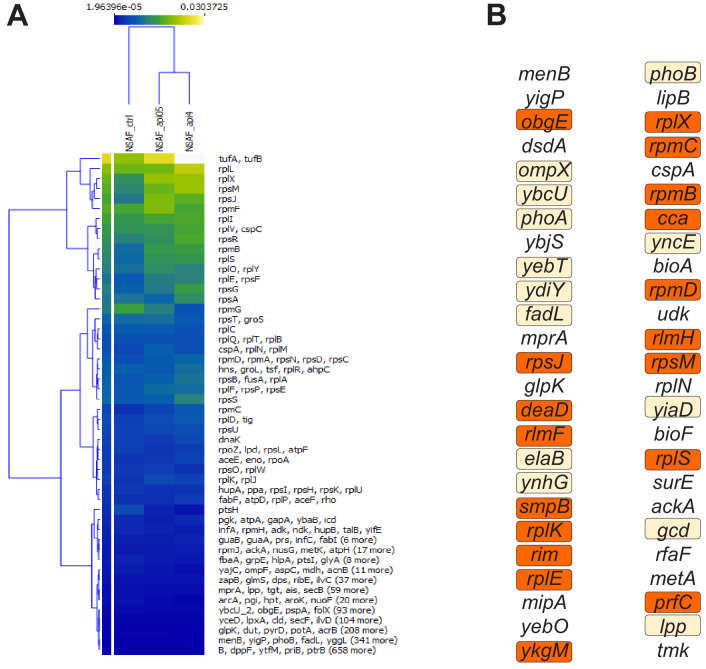
Api-induced changes in protein abundance.(A) Changes in relative protein abundance in E. coli cells exposed to 0.5× MIC and 4× MIC of Api relative to the untreated control cells. The heatmap scale reflects length-adjusted fractional abundance of the protein in the total protein sample (blue – less abundant, yellow – more abundant). Genes are clustered using a hierarchical k-mean clustering algorithm. The color represents the relative abundance of each protein or protein cluster using a normalized spectral abundance factor (NSAF). (B) Top 50 proteins showing significant increase in abundance in the cells treated with 0.5× MIC of Api relative to the untreated control. Proteins related to translation are highlighted in orange. Periplasmic, inner-, and outer-membrane proteins are highlighted in beige.